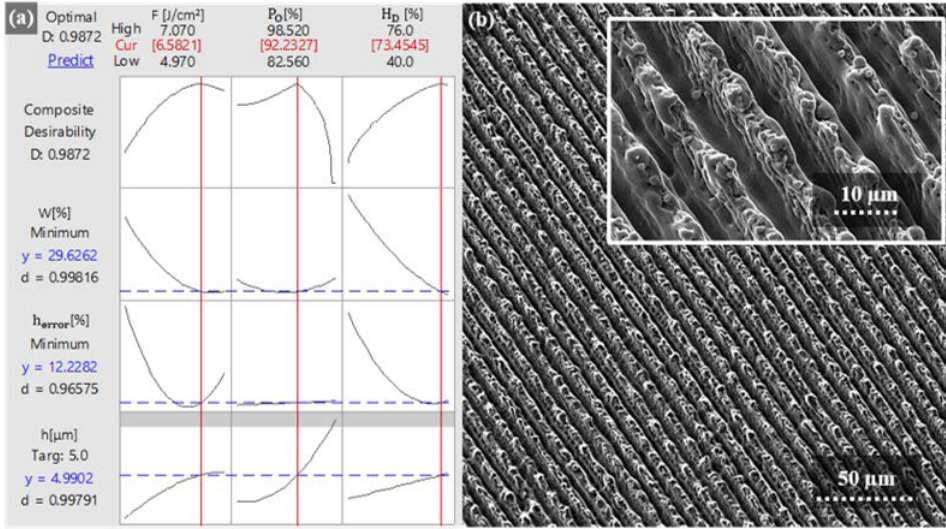
Figure12. Summaryofthemulti-objectiveoptimizationprocesswherein( a )MinitabResponseoptimizer is presented and in ( b ) the Scanning electron micrograph visualizes line-like DLIP microstructures produced on 100Cr6 steel using the processing parameters predicted by the Response